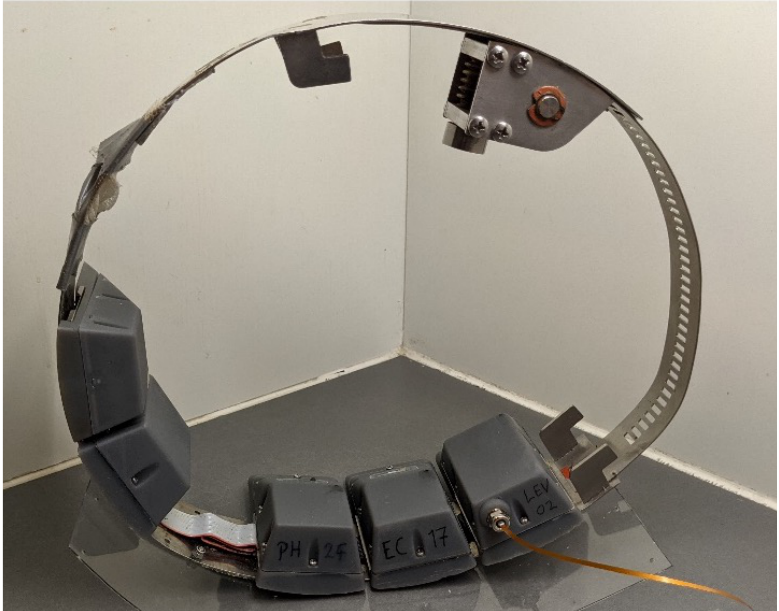
Figure 1. Micromole ring with five modules attached for measuring sewage wastewater physical parameters. From left to right, the attached modules are: battery module, wireless communication module, pH sensor module, Electrical Conductivity sensor module, and a Water Level sensor